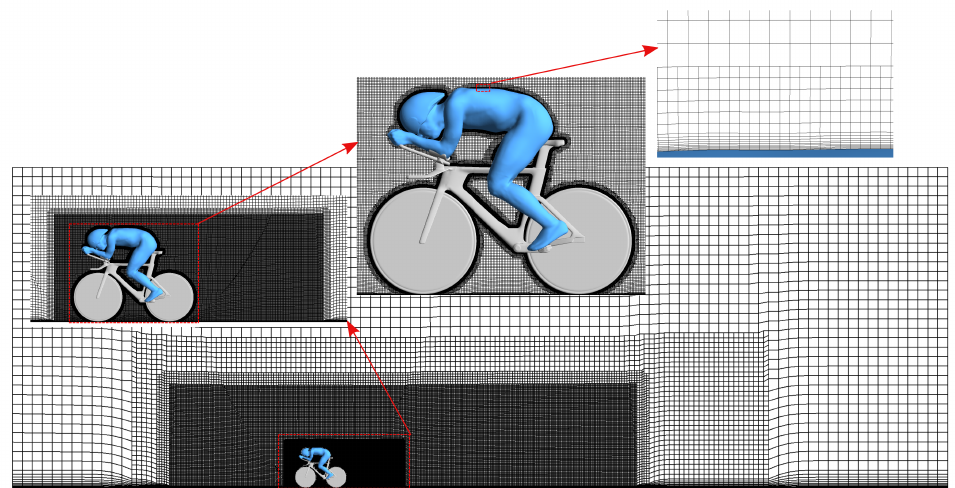
Figure 3. Meshing strategy and local refinement illustrated by the grid of case 2a through the